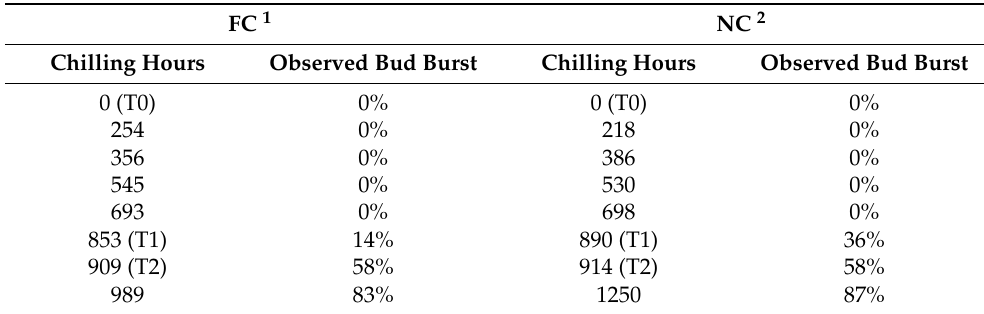
Table 1. Observed budburst from branch samples of Bing variety with different CRs obtained from FC and NC